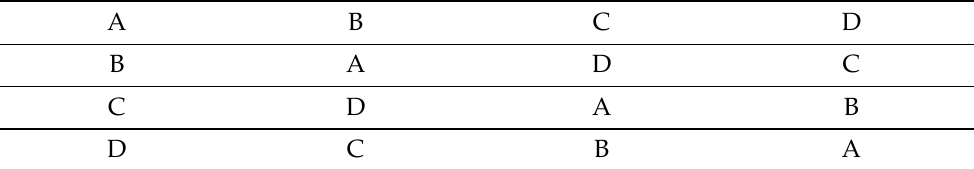
Table 2. The structure of the addition table for the 16 singular Jacobian points of the hyperelliptic curves C 6 and C 7